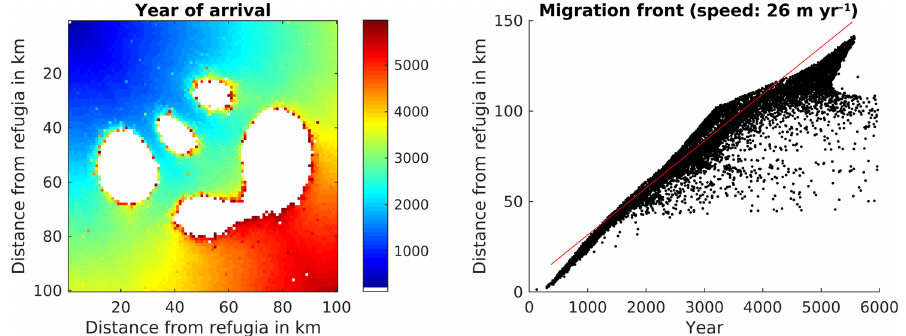
Figure 6. Spread of Fagus sylvatica using the SMSM method through an area of 100 × 100 grid cells with identical climate but the probability of seed fall set to 0.00005 multiplied with the spatially explicit seed dispersal permeability value as shown in Fig. 2. Note that we increased the simulation time to 6000 years in order to have F. sylvatica establishing in all